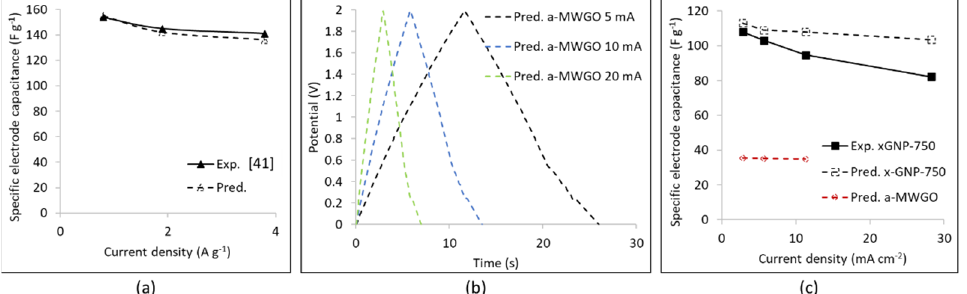
Figure 7. Results of the computer simulations of GCD cycles of a symmetric EDLC with a-MWGO electrodes: ( a ) electrolyte 1M TEABF 4 in ACN: plot of the specific electrode capacitance versus current density and comparison between predictions and capacitance values calculated from the experimental charge-discharge data of [41]; ( b ) electrolyte 1M LiPF 6 in EC:DMC: predicted GCD curves; ( c ) electrolyte 1M LiPF 6 in EC:DMC: plot of the specific electrode capacitance versus current density and comparison between a-MWGO electrode (predictions) and xGNP-750 electrode (predictions and experimental data).